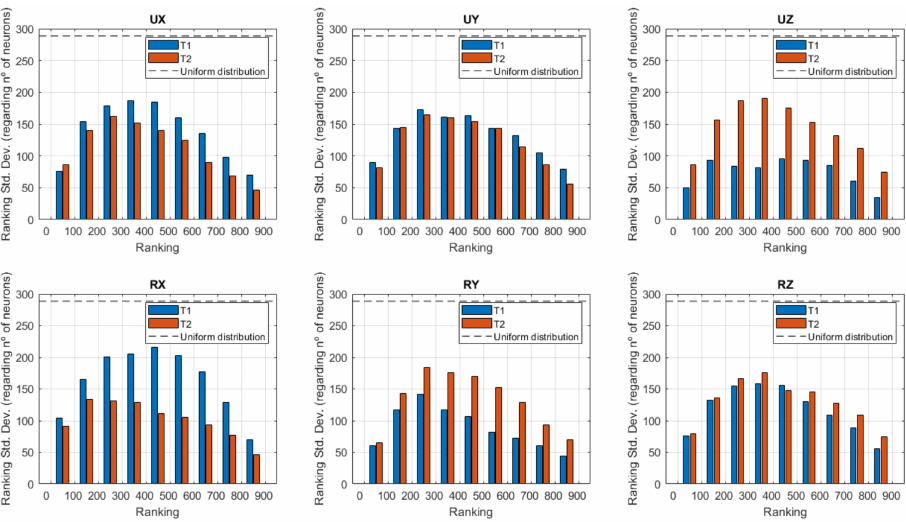
Figure 10. Network ranking dispersion with respect to the number of neurons. Additionally to the relation of the network performance with respect to the number of neurons, possible dependency with respect to the spring directions were also assessed to check if a given network that performs optimally in one direction, should show the same tendency for the rest of directions. To quantify that in an equivalent manner, standard deviation of the rankings with respect to the spring directions were obtained for each number of neurons, as shown in Figure 11. For the sake of clarity, and since the behavior was found to be very similar for all number of neurons, only results for 1, 5, 10, and 15 neurons are included. In this case, it is observed that for mid rankings, no significant dependency between directions can be stated, since dispersions approaches to the one of uniform distribution. In contrast, extreme rankings show once again lower dispersion, meaning that networks with worst and best results will show dependency between spring